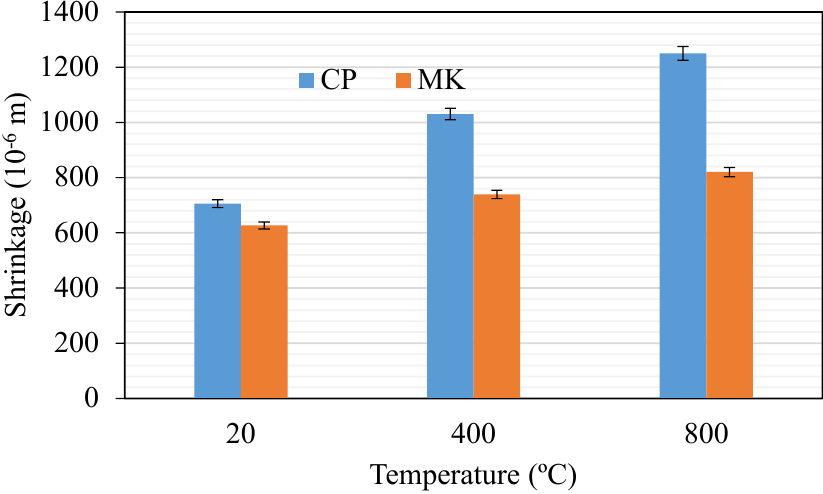
Figure 9. Shrinkage of cement paste and metakaolin-cement paste.